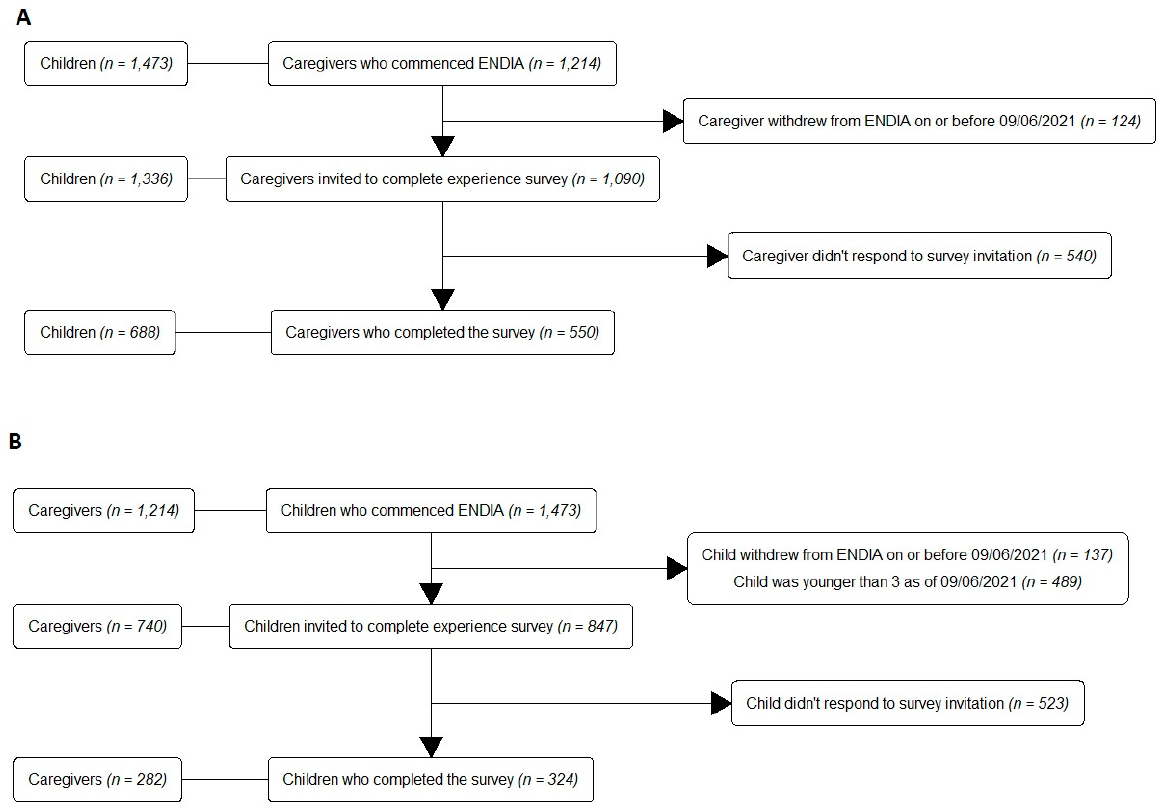
Figure 1. STROBE diagrams for ( A ) the Caregiver Survey, and ( B ) the Child Survey.